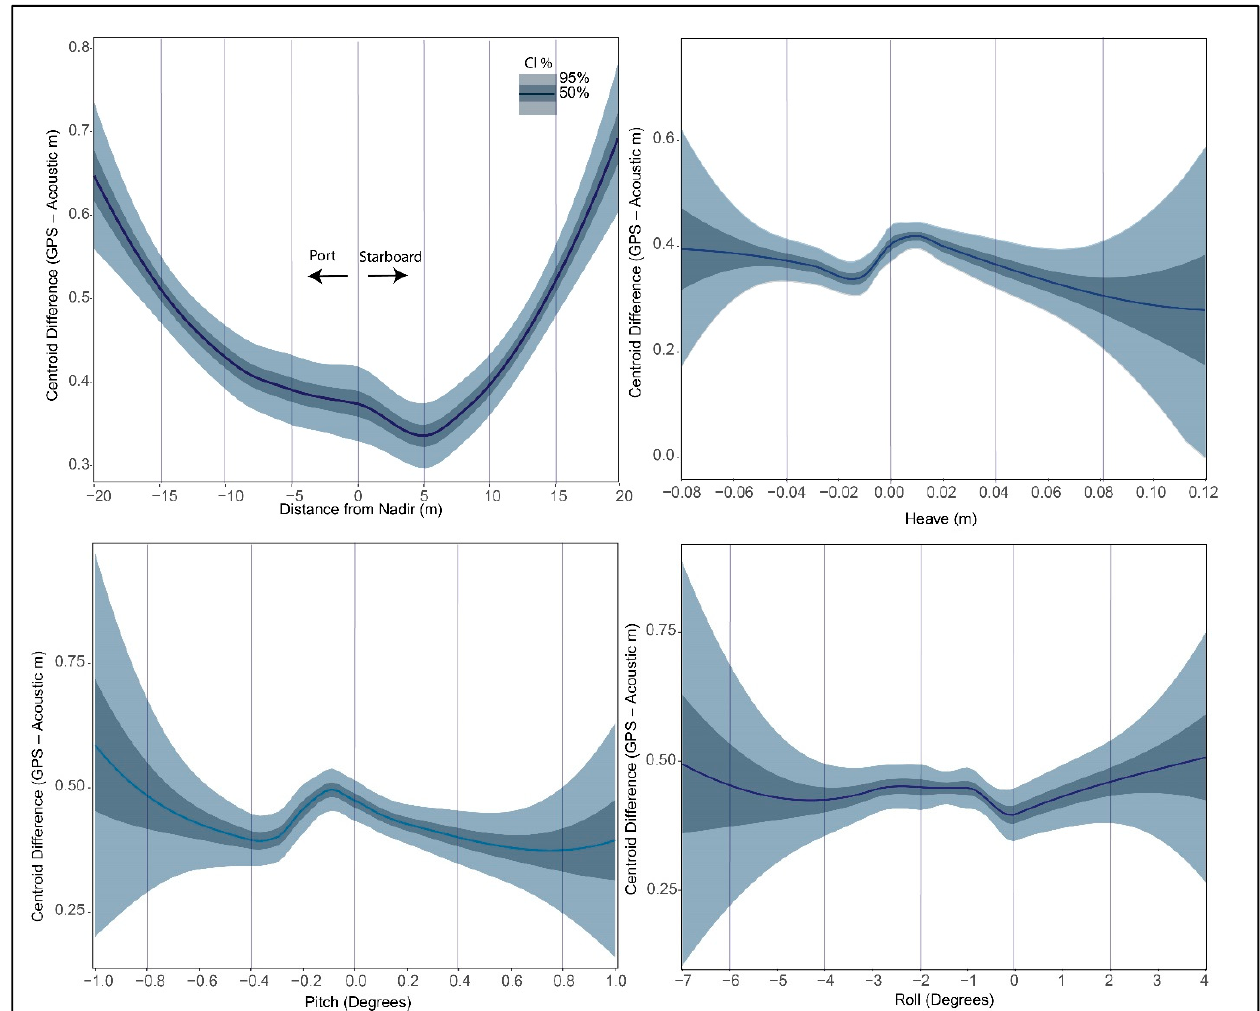
Figure 4. Absolute localization and sources for uncertainty for all sidescan backscatter data. ( Upper left ) distance from nadir. ( Upper right ) Heave in meters. ( Lower left ) Pitch in degree. ( Lower right ) Roll in degrees. CI = Confidence interval.